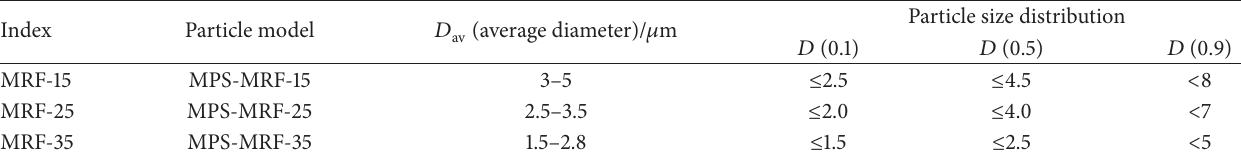
Table 1: Three MRF samples’ index and the corresponding parameter of